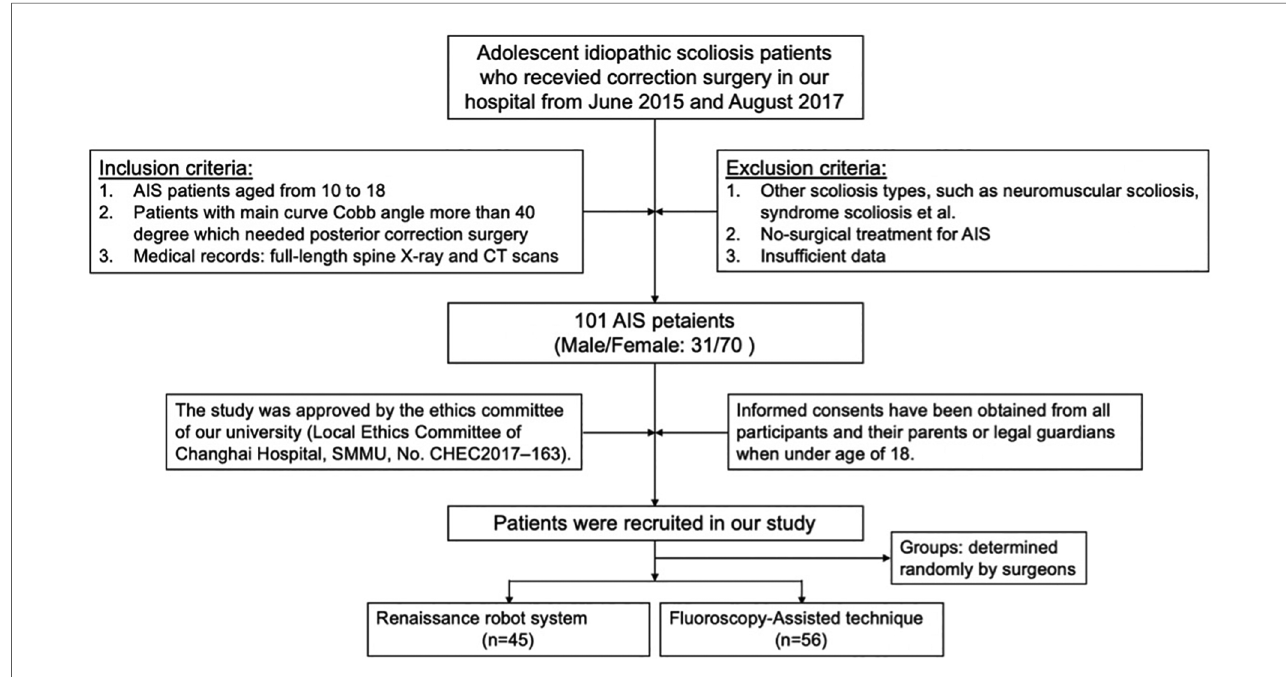
FIGURE 1 Flowchart showed the research methodology.